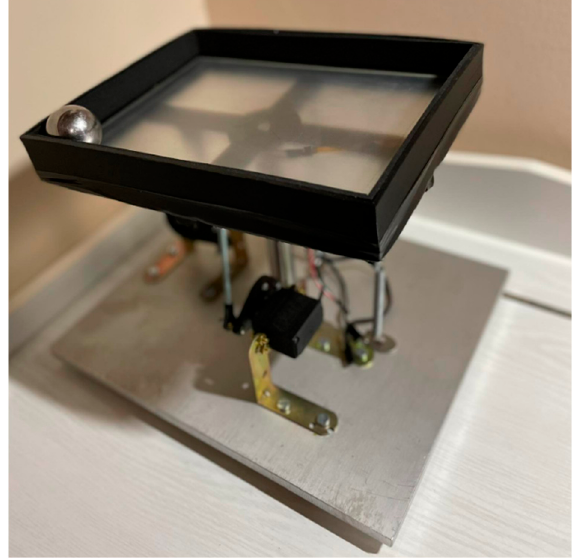
Figure 7. Physical implementation.